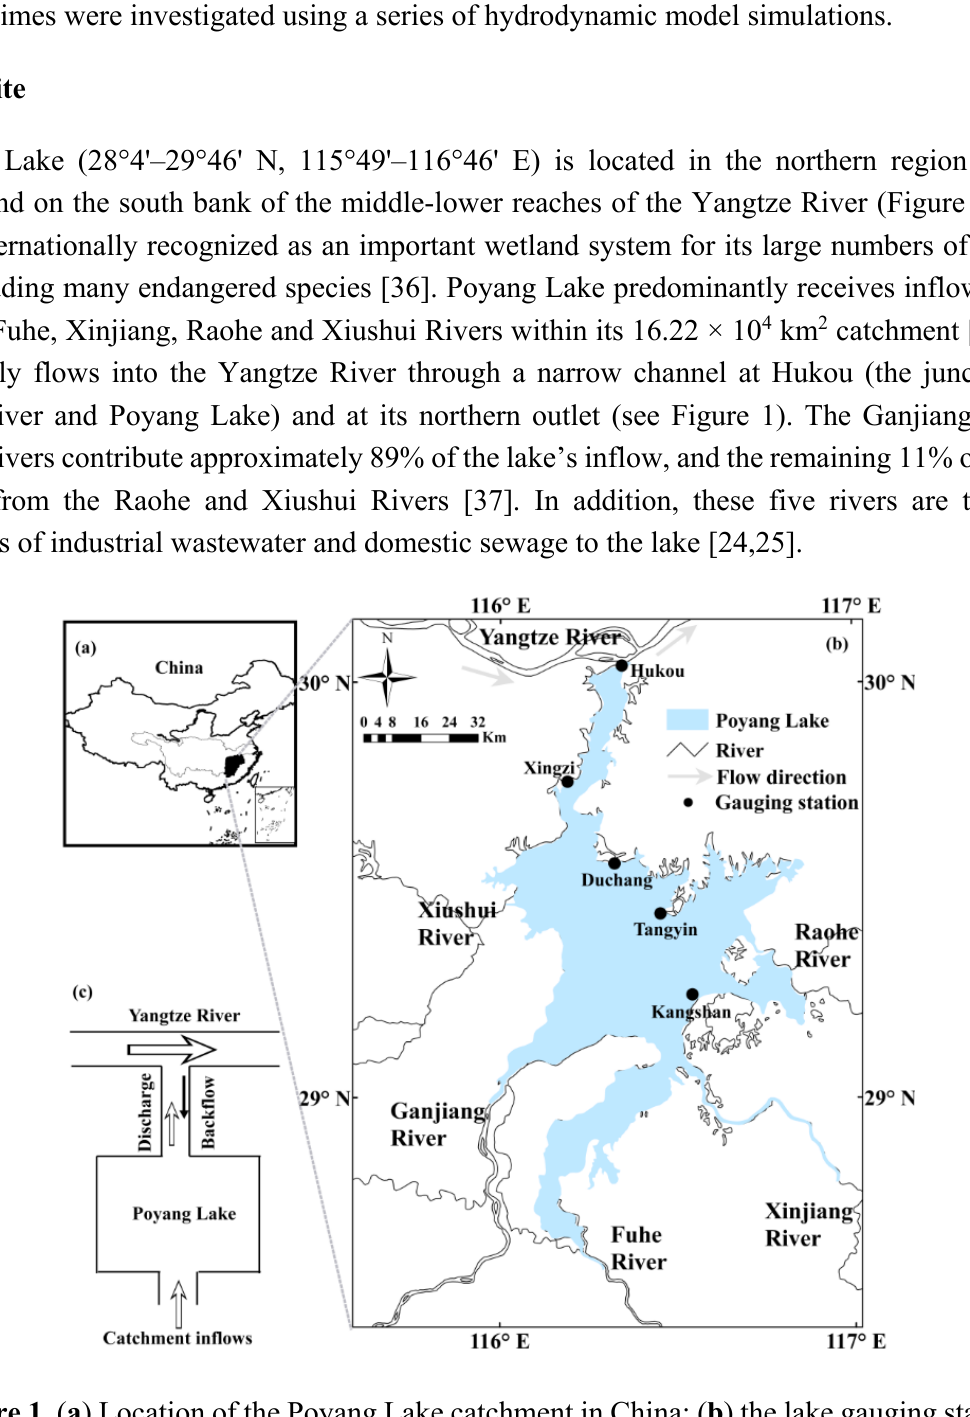
Figure 1. ( a ) Location of the Poyang Lake catchment in China; ( b ) the lake gauging stations and the major rivers surrounding the lake and ( c ) a schematic diagram of the river-dominated lake